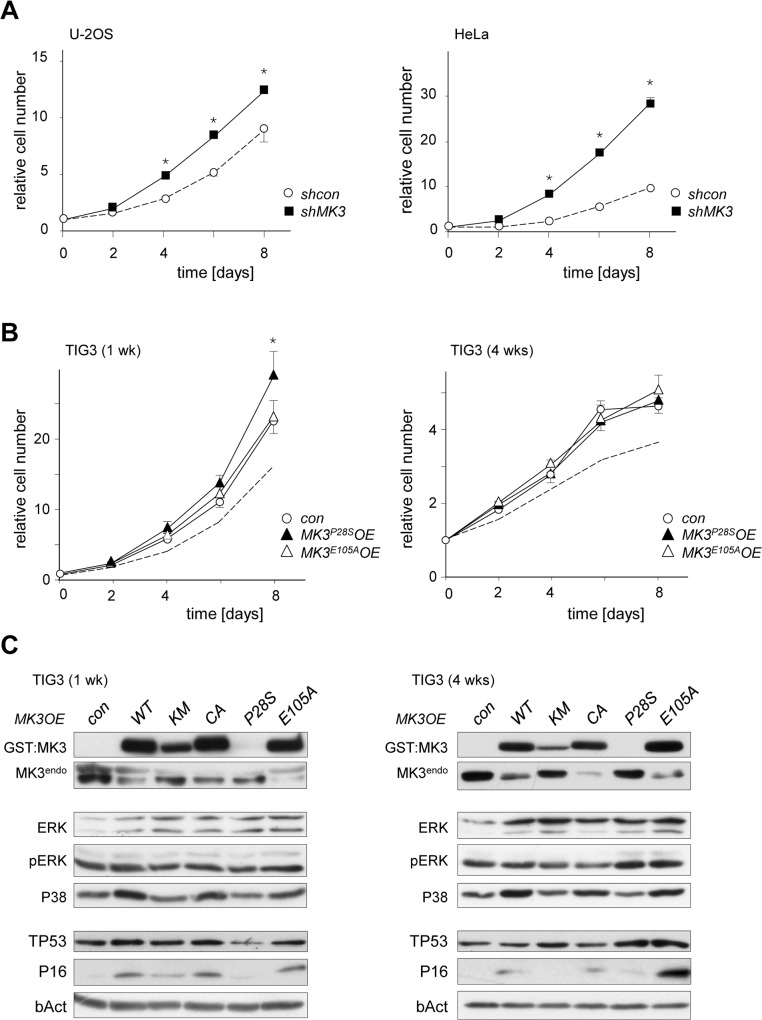
Modulation of MK3-levels leads to M/SAPK signalling imbalance.(A) Proliferation profiles of U-2OS/shMK3 cells (left panel; filled squares)) and HeLa/shMK3 cells (right panel; filled squares) versus control (shcon; open circles). (B) Proliferation profiles of TIG3 cells expressing MK3 mutants MK3P28S (MK3
P28S
OE; filled triangles) or MK3E105A (MK3
E105A
OE; open triangles) at 1 week post-transduction (left panel) and 4 weeks post-transduction (right panel). The dotted lines in the graphs represent the MK3WT proliferation profiles, as depicted in S2A Fig. Cell counts at t = 2 through t = 8 (A, B) were normalized to cell counts at t = 0 for each transduced cell culture individually (see Methods section for details); statistical significance was determined by two-tailed Student’s t-test and is presented relative to the empty vector control (* p < 0.05). (C) Protein expression profiles of GST-tagged MK3 (GST:MK3), endogenous MK3 (MK3endo), ERK, phosphorylated ERK (pERK) P38, TP53 and p16INK4A (P16) in TIG3 cells at indicated timepoints post-transduction (corresponding to Fig 4B); loading controls: b-Actin (bAct).